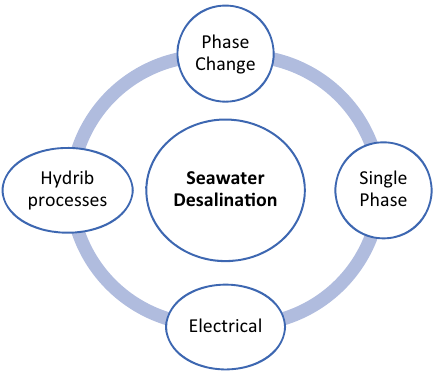
Figure 14: Classi fi cation of seawater desalination